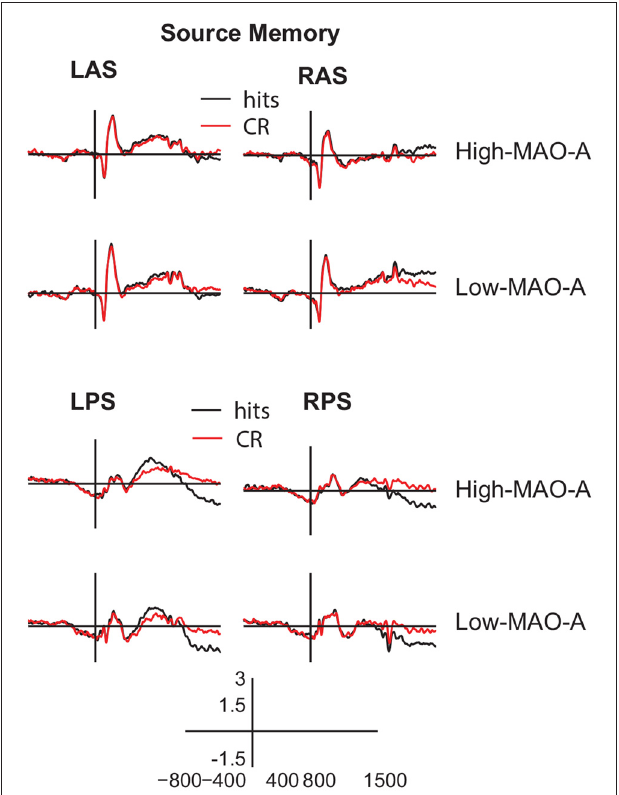
FIGURE 6 | ERP waveforms during source memory retrieval. Averaged ERP waveforms from − 800 ms to 1500 ms post-stimulus presentation (y axis crosses at 0 ms) in the (LAS, top left panels), (RAS, top right panels), (LPS, bottom left panels), and (RPS, bottom right panels) ROIs for hits (black) and CRs (red) during the source memory task. The gray box represents the main effect of group for the late frontal old/new effect where ERP amplitudes in the Low MAO-A group were higher than the High MAO-A group. However, there were no significant condition by group interactions during source memory.